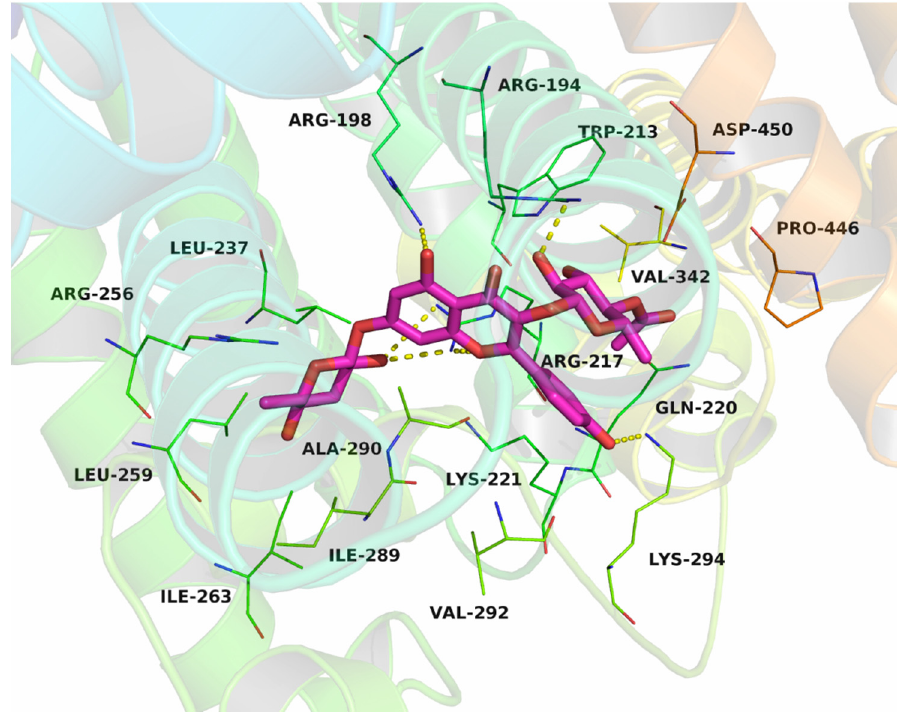
Figure 12 . Compound 6 was docked into the Site I (IIA) binding pocket of the BSA. Figure 12. Compound 6 was docked into the Site I (IIA) binding pocket of the